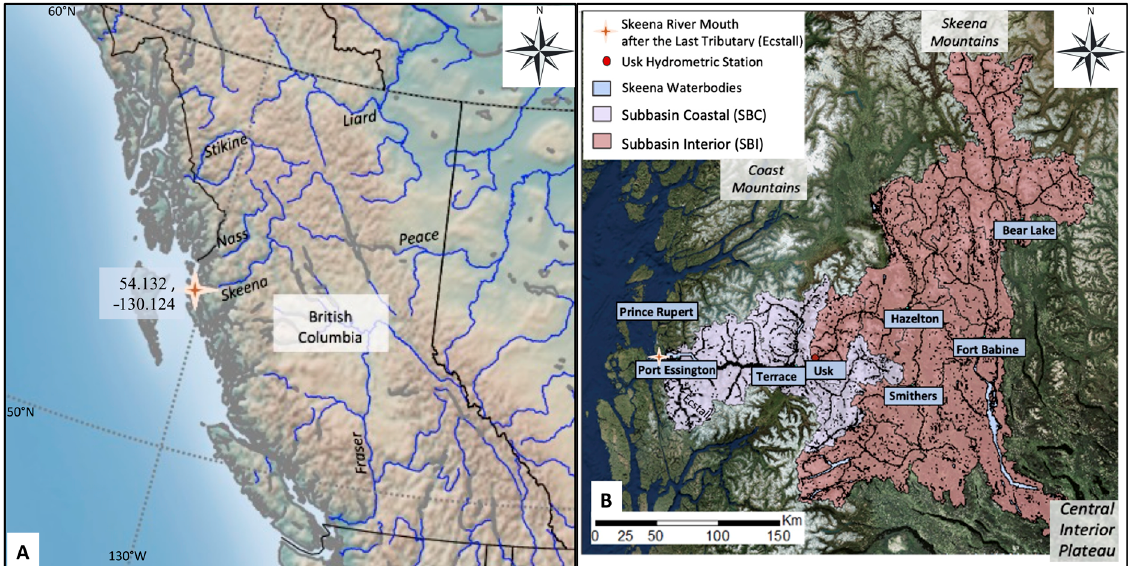
Figure 1. ( A ) The Skeena River in northwestern, British Columbia, Canada. ( B ) Interior areas up- stream (SBI) and coastal catchment areas downstream (SBC) of Usk hydrometric station. Notice the northwest-trending Coast and Skeena Mountain chains along with the glaciated areas of the basin (right). Major town names are added for reference.